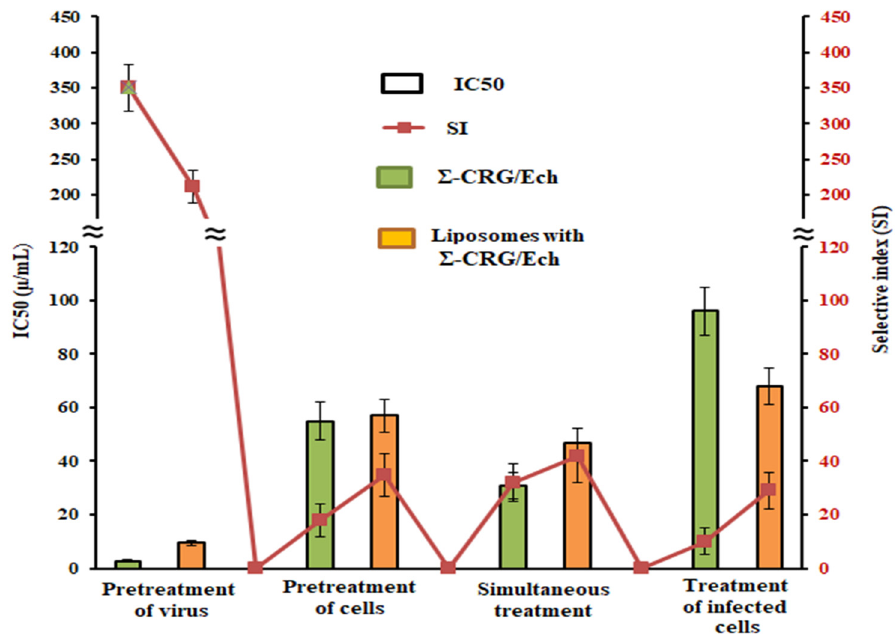
Figure 5. The anti-HSV-1 activity of the Σ -CRG/Ech complex and its liposomal form at the different treatment schemes. The antiviral activity of the compounds was determined by the plaque reduction assay and was expressed as a 50% inhibitory concentration, IC 50 (columns), and a selective index, SI (line). Σ -CRG/Ech, carrageenan complex with echinochrome; liposomes with Σ -CRG/Ech, liposomal form of the complex. The results were obtained by applying compounds at different stages of the HSV-1 infection, and each data point represents the mean value ± SD of three independent experiments.